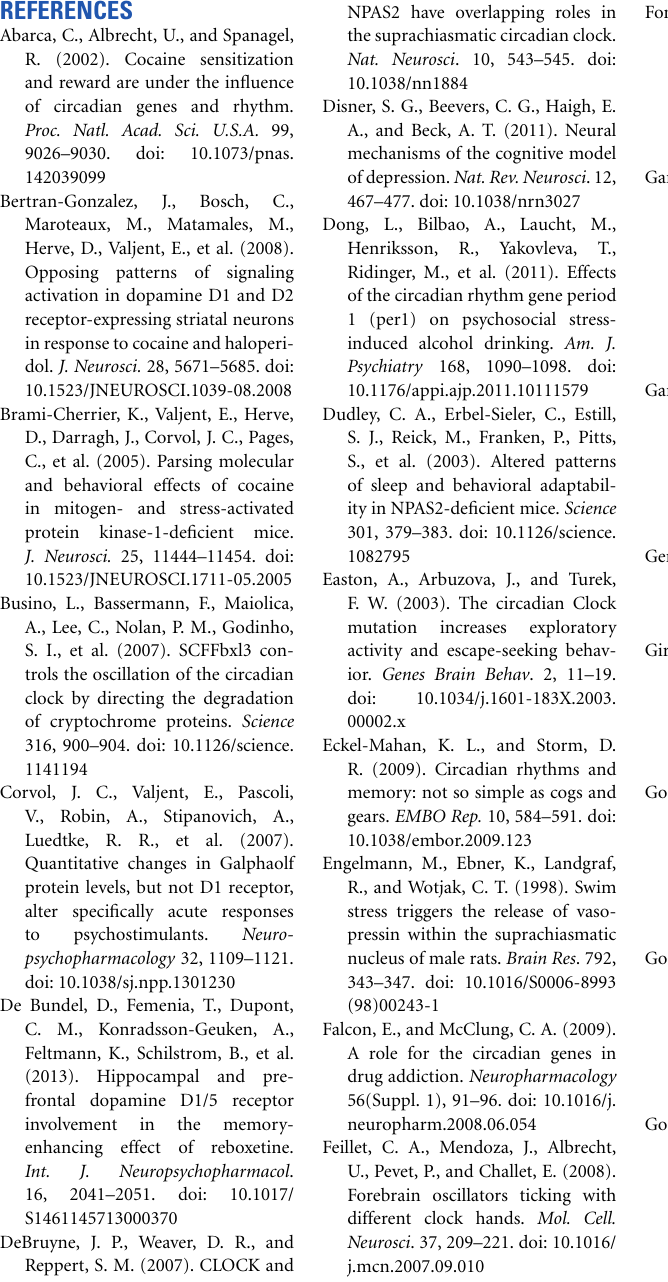
NPAS2 have overlapping roles in the suprachiasmatic circadian clock.